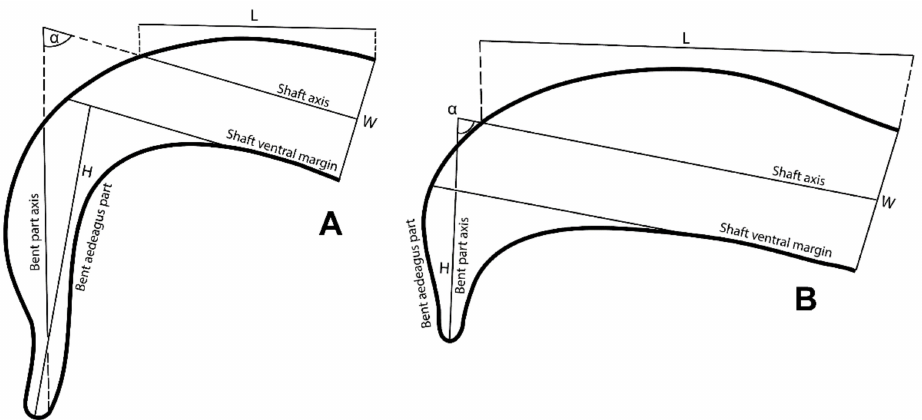
Figure 3. Morphological parameters (H: the height of the bent aedegal part; L: the length of the shaft dorsal margin; W: the width of the shaft, and α : the angle formed between the shaft axis and the axis of the bent part) that was measured for comparison of the key differential character of the male aedeagus, among different collected spider mite samples, representing the ( A ) claimed Mexican Oligonychus punicae (bent part tip bends posteriorly), and ( B ) O . punicae (bent part tip